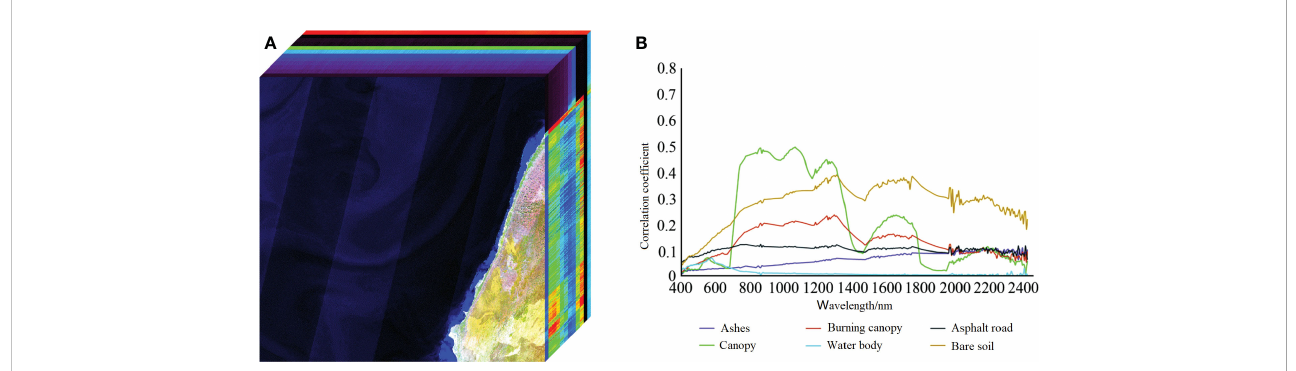
FIGURE 1 Hyperspectral 3D data from the Sentinel-2 satellite along the northern coast of Australia, (A) UTM zone 49S, (B) Spectral curves of different